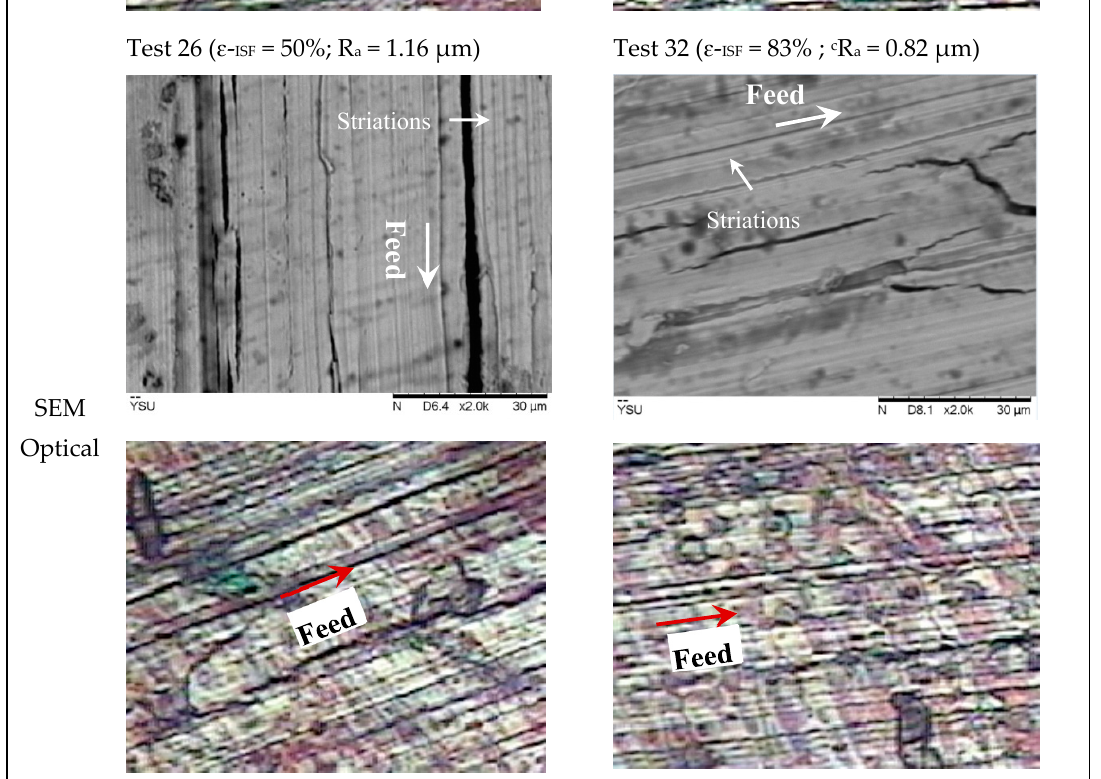
Figure 9. Morphology of the unformed surface and representative formed contact surfaces.